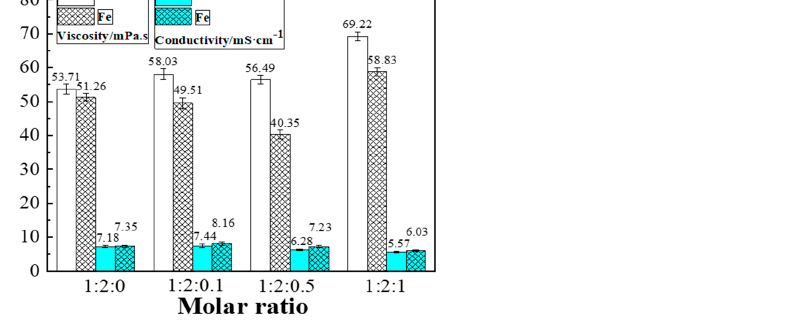
Figure 3. A 3D structure diagram of the 1:2:0.5 TDES. 2.2. Effect of TDES on Fe (III)/Fe (II) At two different scanning rates in Figure 4, with different additions of glycerol, the peak potential difference decreases at 1:2:0.5, the reversibility is the strongest compared with other ratios, and the peak current density is the largest. With the sweep rate from 50 mV·s − 1 to 100 mV·s − 1 , the peak current densities of 1:2:0.1 and 1:2:0.5 increase from 55.00 A·m − 2 , 59.59 A·m − 2 to 55.59 A·m − 2 , 79.46 A·m − 2 , respectively. The increase rate of 1:2:0.1 is obviously weaker than that of 1:2:0.5. It is speculated that the addition of a small amount of glycerol has no effect on the reconstruction of the hydrogen bond network after the sweep rate increases. It reveals the importance of the appropriate molar ratio of the com- ponents for the construction of a hydrogen bond network. In the above experiment, the background current of electrolyte lower than 0.1 mol·L − 1 is larger. In order to avoid back- ground subtraction and simplify data analysis, an electrolyte with a concentration of 0.1